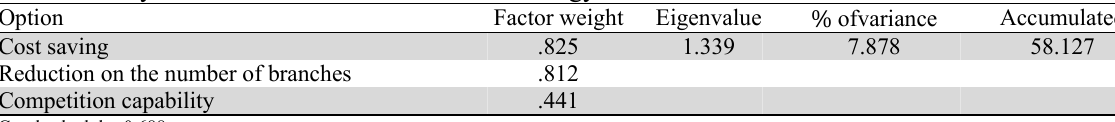
The summary of factors associated with cost strategy Option Factor weight Eigenvalue % ofvariance